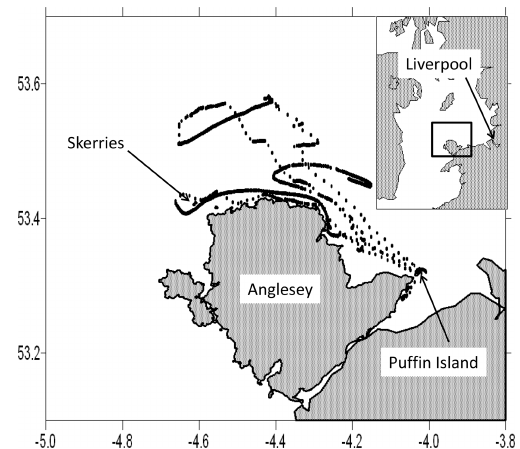
Figure 1. The study site and the track of one of the tagged birds over the period 17 to 21 May 2012. When the bird is flying from its base on Puffin Island the points are relatively widely spaced. When it is sitting on the water, they are closely spaced and the movement is consistent with that of travelling with the tide. Labels on axes show latitude in degrees north and longitude in degrees east. The inset map shows the position of the study area within the Irish Sea and relative to Liverpool, which lies 70km east of Puffin